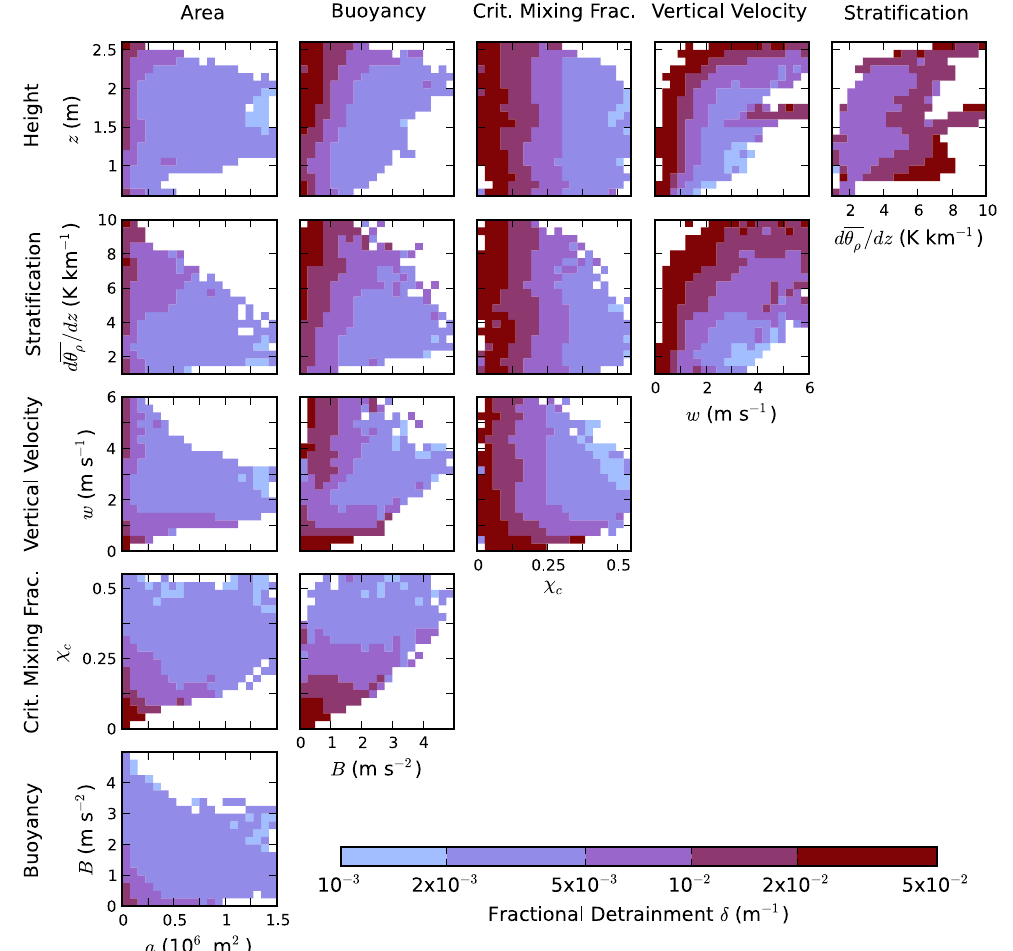
Fig. 8. Mean values of log 10 (δ) for each bin of joint probability density functions for various cloud core properties of individual clouds in the combined BOMEX and ARM LES output. The y axis of each row shows height, environmental stratification, critical mixing fraction, buoyancy, and vertical velocity (from top to bottom), and the x axis of each column shows cross-sectional area, vertical velocity, buoyancy, critical mixing fraction, and environmental stratification (from left to